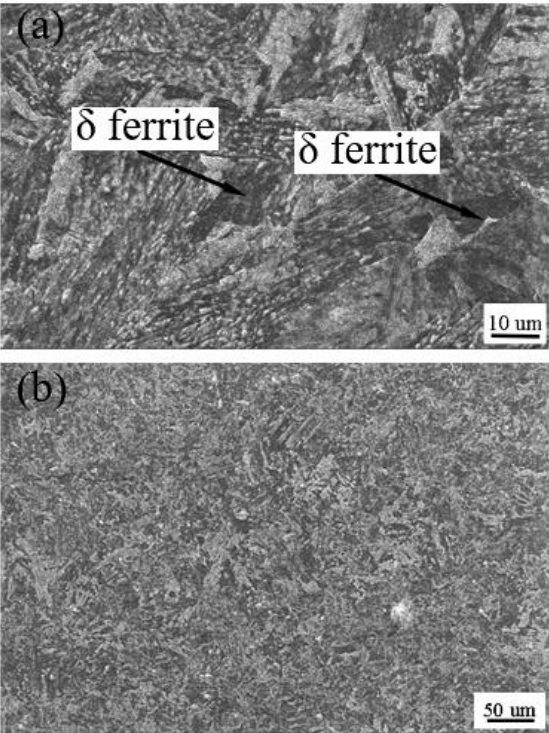
Figure 14. Microstructure of welding zone (amplification of Figure 13) ( a ) before quenching and tempering treatment (SEM), and ( b ) after quenching and tempering treatment (SEM).